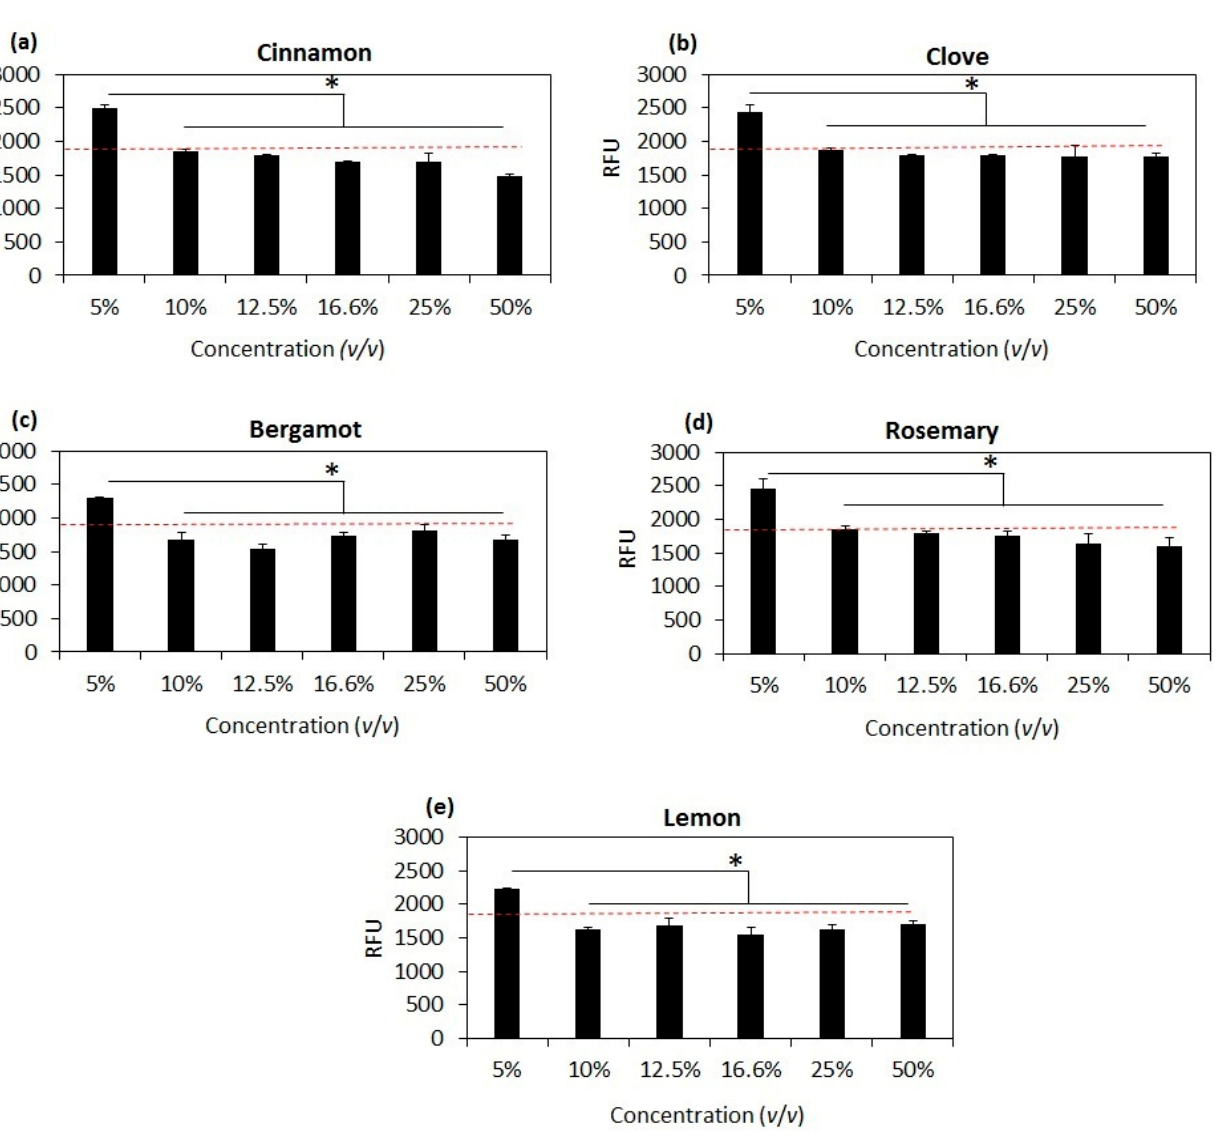
Figure 4. Minimum Inhibitory Concentration (MIC) of tested EOs by alamarBlue colorimetric assay; ( a ) cinnamon oil; ( b ) clove oil; ( c ) bergamot oil; ( d ) rosemary oil and ( e ) lemon oil; the red line indicates the Relative Fluorescent Unit (RFU) of the solution of 0.00015% alamarBlue in PBS as a control sample. * indicates p -value < 0.05.